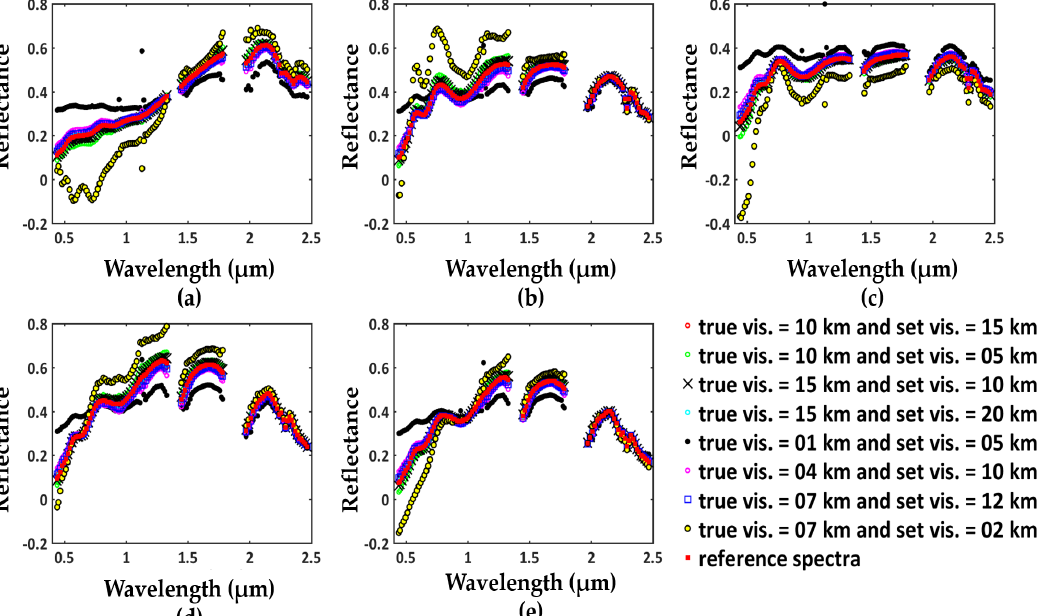
Figure 19. Effects of scattering and variation in visibility on spectral qualities of five endmembers ( a – e ) used to generate the geological dataset with spectrally similar